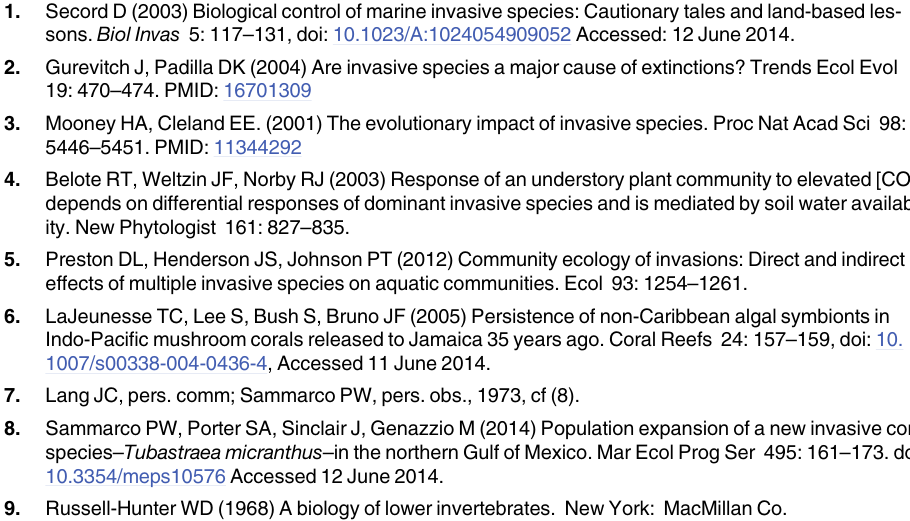
S1 Table. Raw data, species competition matrix for Tubastraea micranthus and T . coccinea , competition results, by species. S2 Table. Summary data, Tubastraea micranthus and T . coccinea , competition data, results by